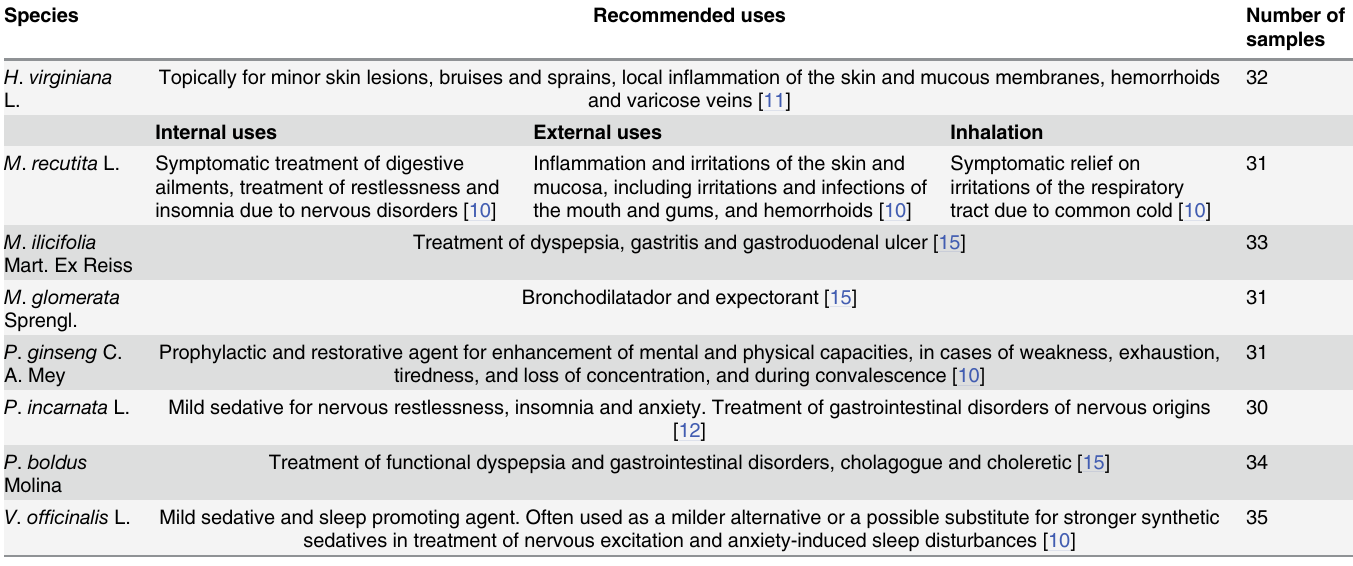
Table 1. Species analyzed in this study and their therapeutical recommendations. Recommended uses Number of